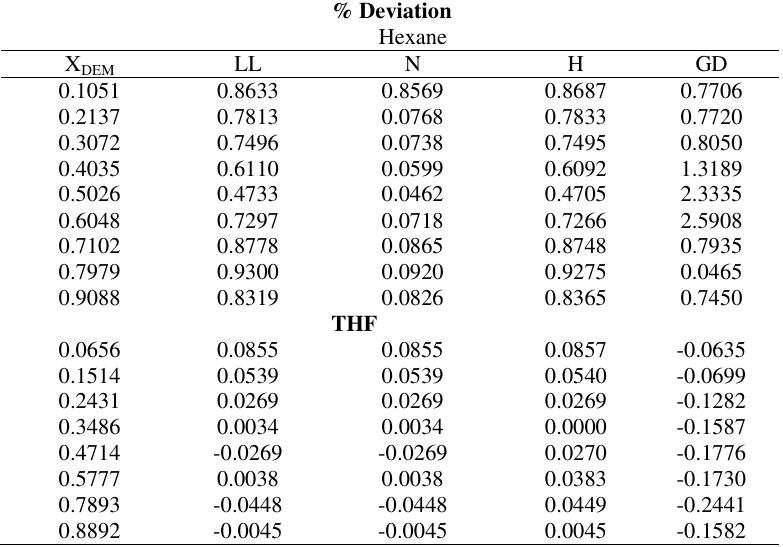
Table-3. Percentage deviation between theoretical and experimental values of refractive index of binary liquid systems at